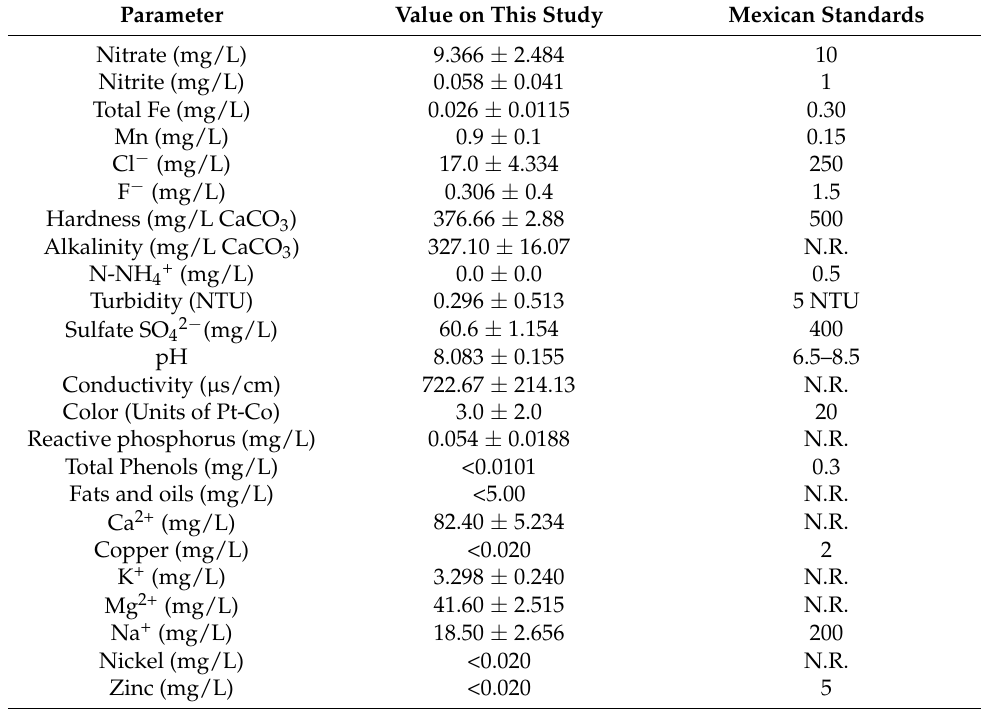
Table 11. Physicochemical characteristics of the evaluated well in comparison with what is established in the modification of NOM-127-SSA1-1994. Parameter Value on This Study Mexican